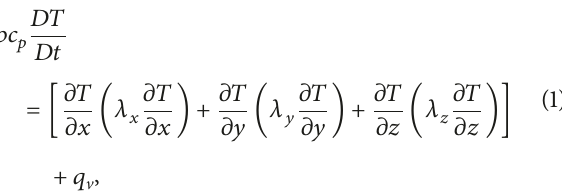
Figure 2: Thermal conductivity of the Ti (Grade 2) and Al (AW 5754)